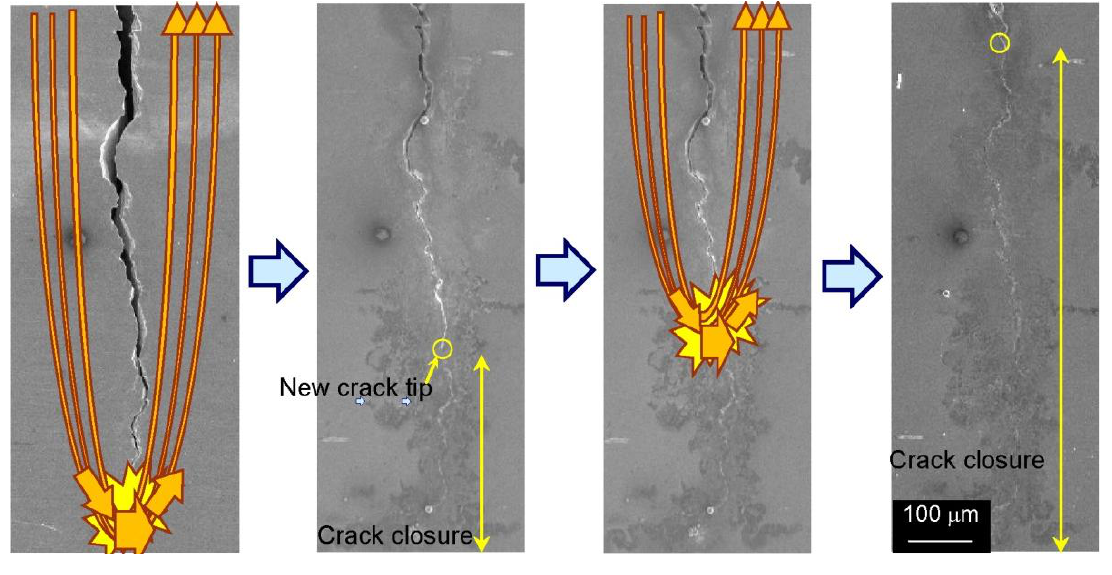
Figure 12. Closure of entire fatigue crack by multiple applications of high-density